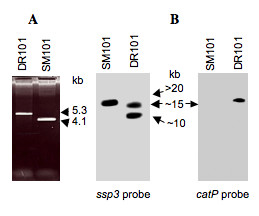
Molecular analysis of ssp3 knock-out mutant. (A) PCR analysis of the total DNAs from C. perfringens wild-type and ssp3 mutant. Total DNA isolated from wild type SM101 and the ssp3 mutant DR101 strains was subjected to PCR analysis using ssp3-specific primer pair CPP13/CPP16. (B) Southern hybridization analysis of total DNAs from C. perfringens wild-type and ssp3 mutant. Two identical Southern blots were prepared using HpaI-digested DNAs from wild-type (SM101) and ssp3 mutant (DR101) and probed separately with either ssp-specific or catP-specific DIG-labeled probes. The migration of the hybridizing band derived from each strain is indicated between the two blots.